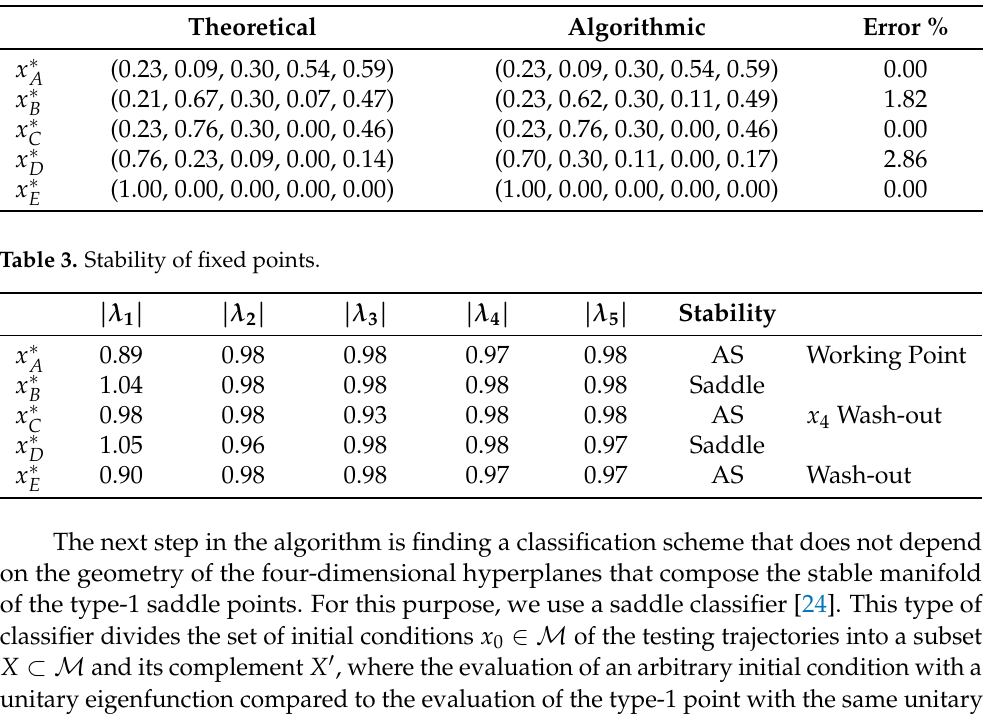
Table 2. Location of fixed points.